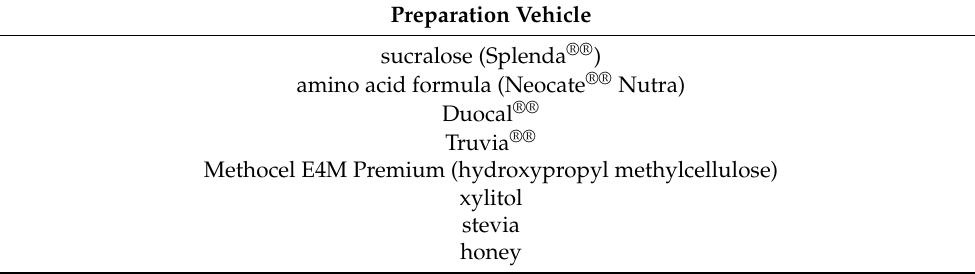
Table 2. Vehicles used in preparation of